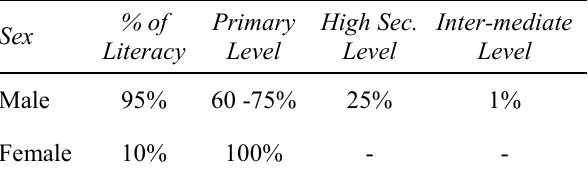
Table 3: Literacy level of HIV+ people in Agra